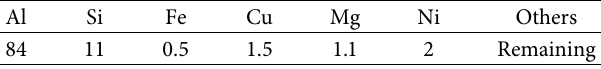
Table 1: Elemental composition of LM13